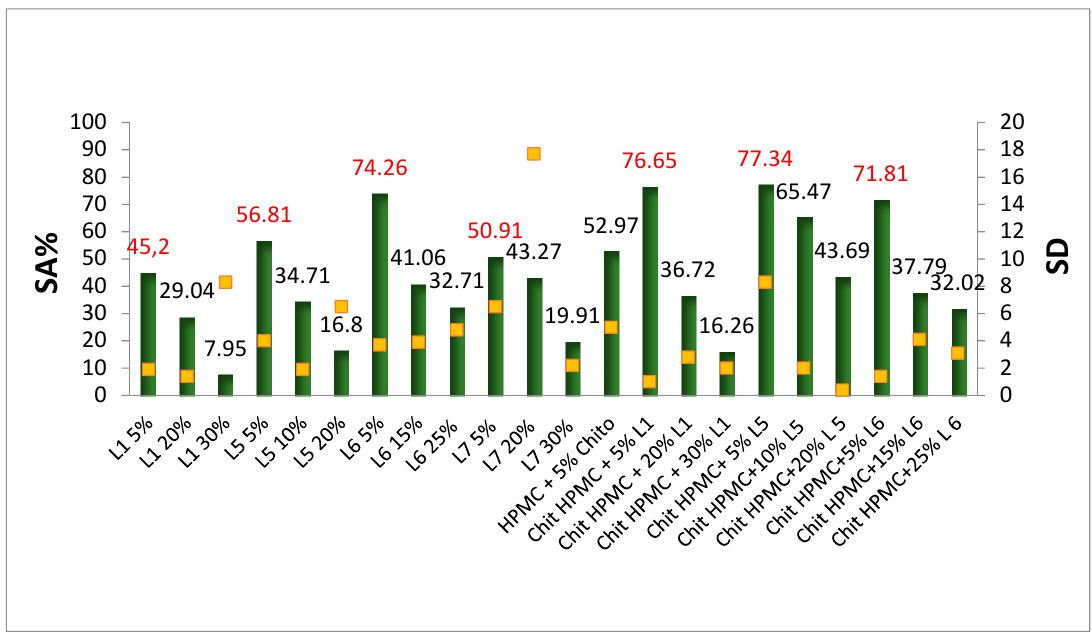
Figure 5. Antioxidant activity of HMPC / lignin and HPMC / lignin / chitosan films. The measurements were held in triplets. The red data labels indicate the highest activity for each lignin type. The yellow points relate to the standard deviation.